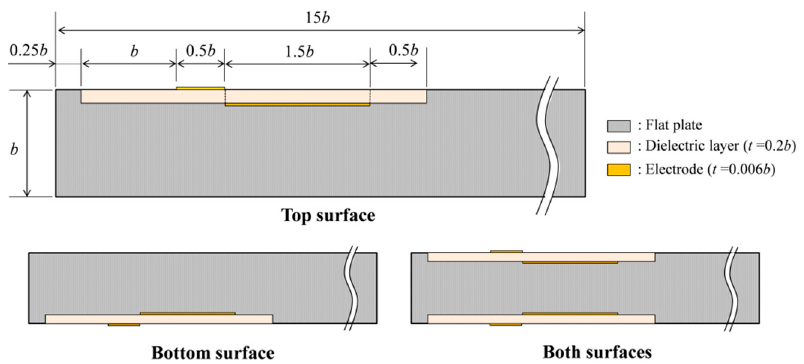
Figure 3. Cross-section of plasma